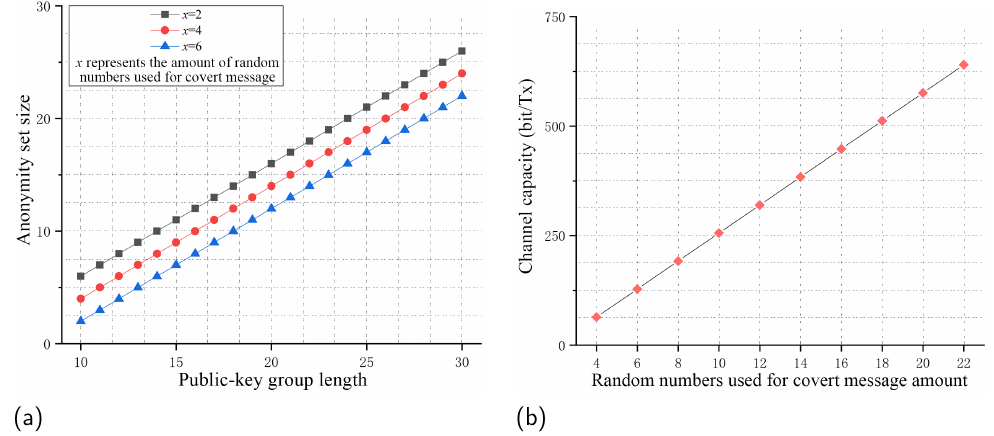
Figure 4. ( a ) shows the relation between the length of the public-key group and the size of the anonymity set when the degree of embedding of the covert information is the same (i.e., the same channel capacity), and ( b ) shows the relation between the number of random numbers occupied by the covert information and the channel